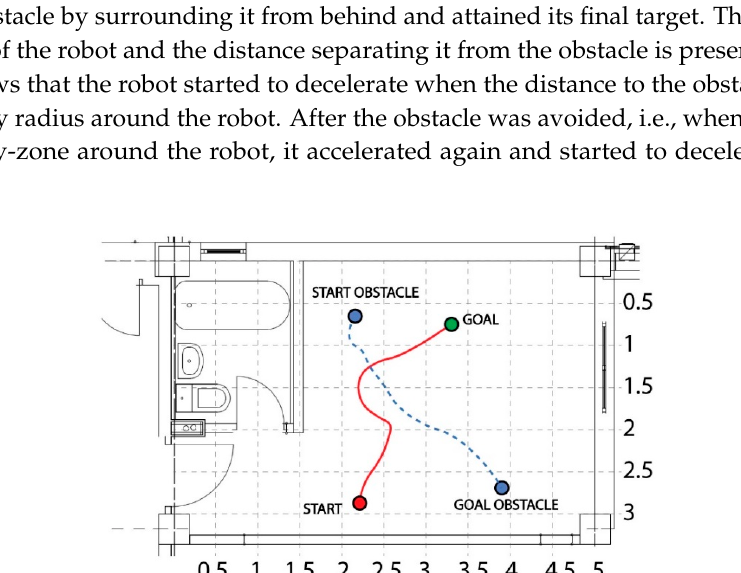
Figure 14. Dynamic obstacle avoidance.